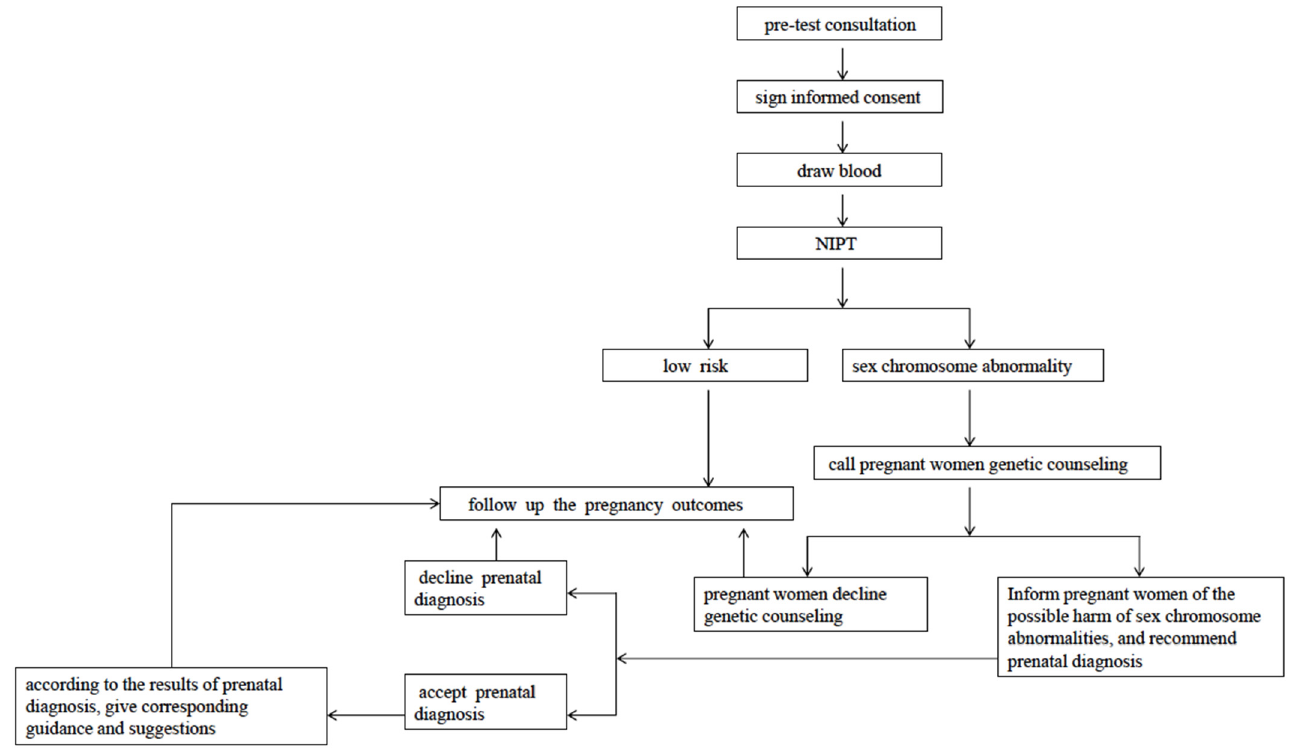
Figure 1. The detection of sex chromosome abnormalities by non-invasive prenatal screening.